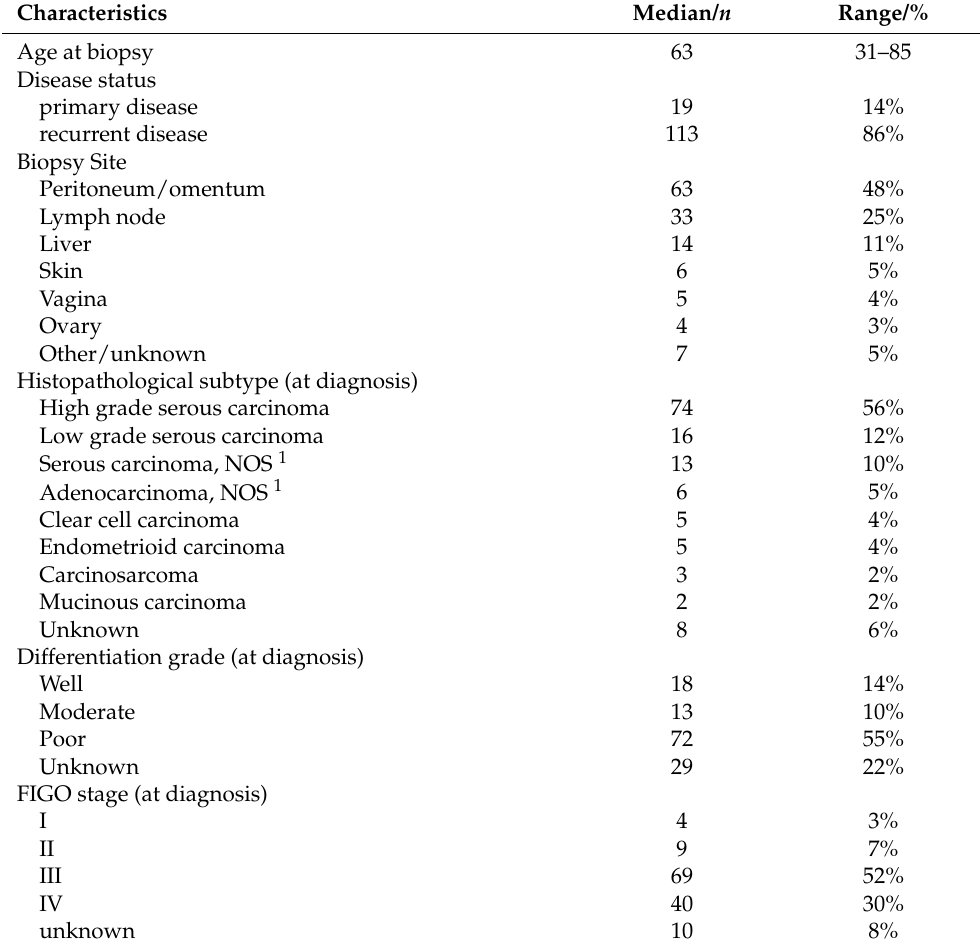
Table 1. Baseline table with clinical cohort characteristics of 132 patients.